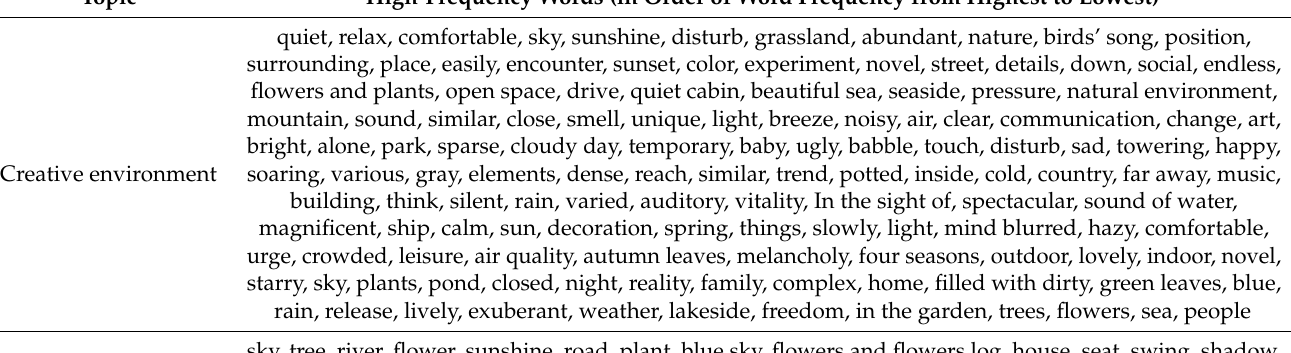
Table A15. High-frequency word list.